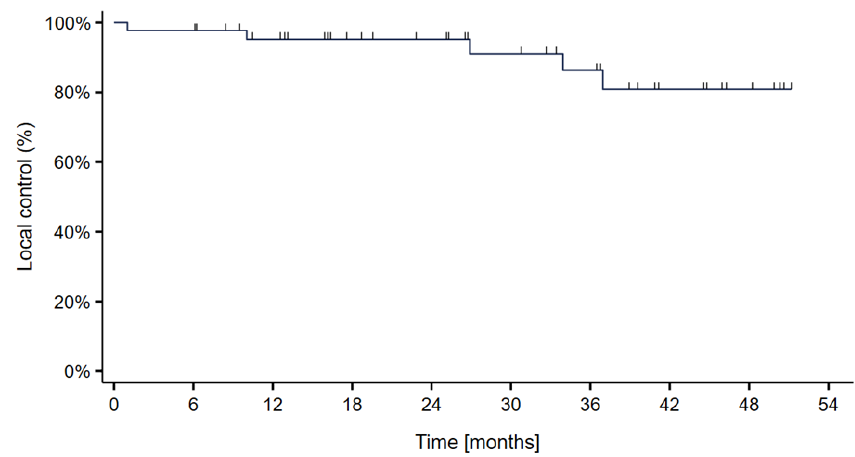
Figure 2. Kaplan–Meier curve showing the local control probability in 44 skull-base chordoma Figure 2. Kaplan – Meier curve showing the local control probability in 44 skull-base chordoma pa- tients treated with particle therapy at MedAustron. patients treated with particle therapy at MedAustron.